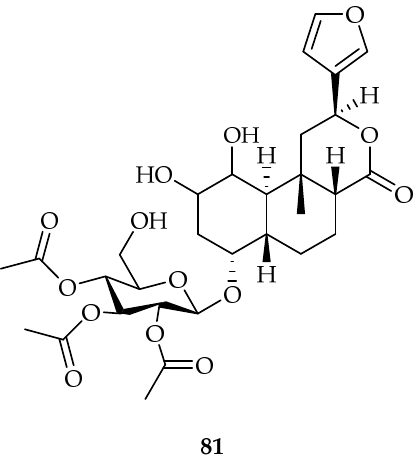
Figure 32. Structure of TC-2 81 [50].